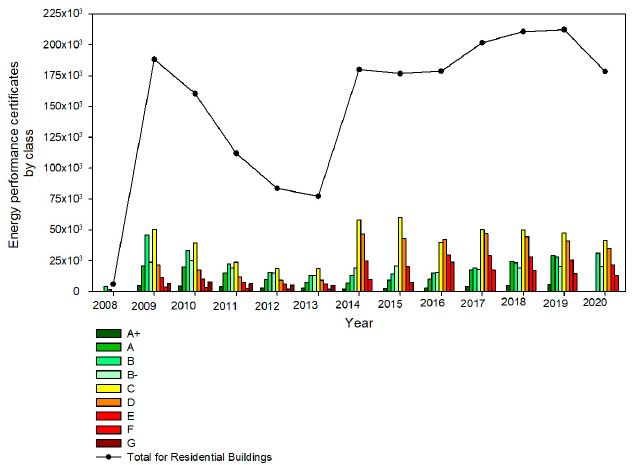
Figure 14. Energy performance certificates emitted between 2008–2020 in Portugal by label class (data source [74]).